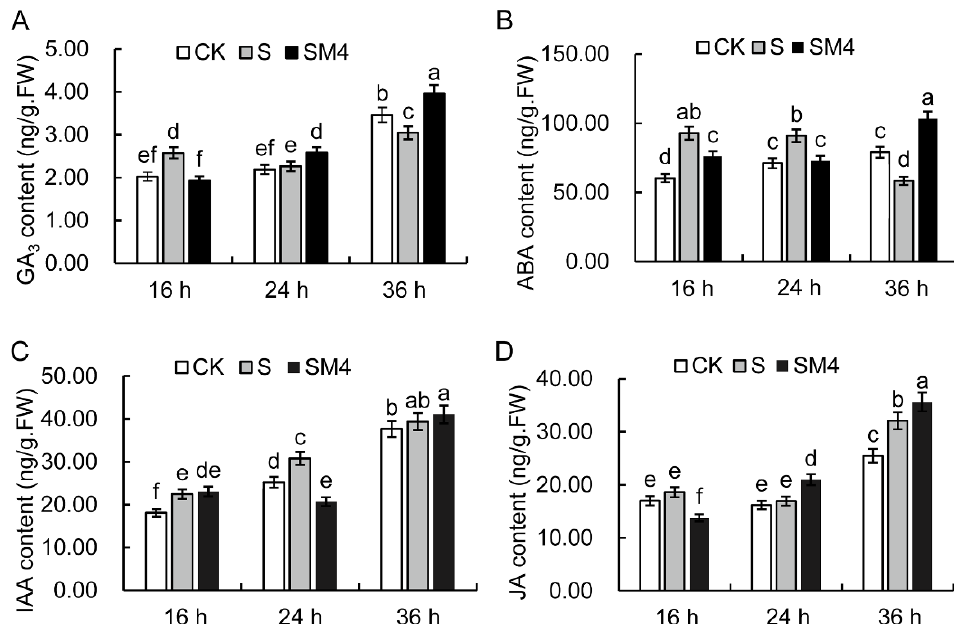
Figure 2. Changes in different hormones in wheat seedlings under water control (CK), salt stress (S), and salt stress with 200 µ M MT (SM4) treatment at different time points (16 h, 24 h, 36 h). ( A – D ) Changes in the content of GA 3 ( A ), ABA ( B ), IAA ( C ), and JA ( D ). The error bar in the figure represents the standard deviation (SD, n = 3). Different letters indicate significant differences by the Duncan test ( p < 0.05).